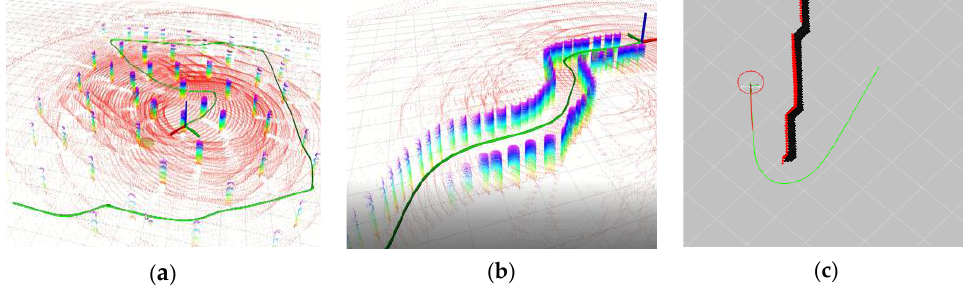
Figure 16. Planned path in ( a ) forest scenario; ( b ) narrow channel scenario; ( c ) long wall scenario. Here the 3D point clouds of the environment are depicted with different colors.